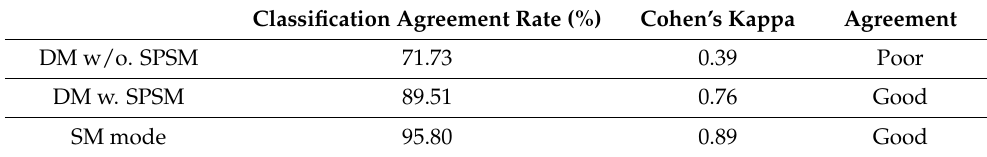
Figure 8. Scatter plots and Bland–Altman plots of α ( a , b ) and β ( c , d ) measured by DM w. SPSM and sonographers. Table 4. Classification performance of DM w/o. SPSM, DM w. SPSM, and SM mode. Classification Agreement Rate